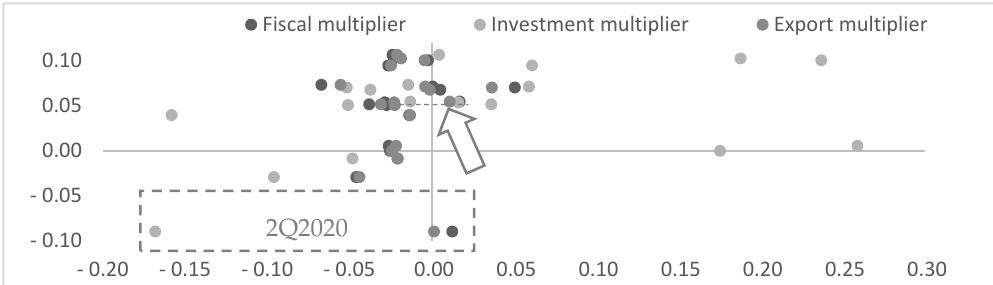
Figure 15. Correlation of changes in autonomous expenditure multipliers to GDP—Poland, own work, source: Eurostat.